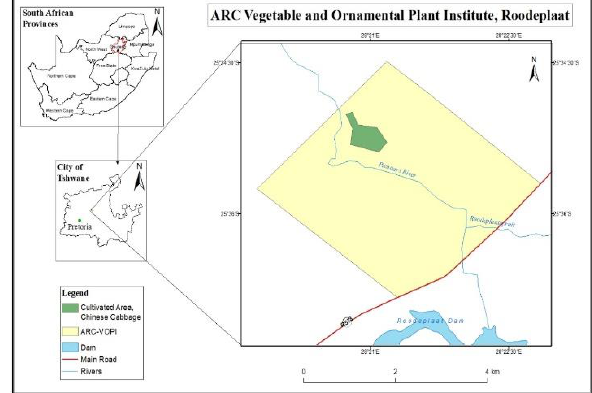
Figure 1. Location of the Study Area